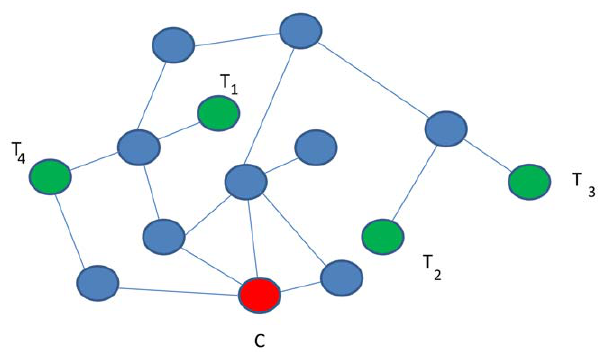
Figure 4. A hypothetical interaction network to be used with Exercises 5 and 6.